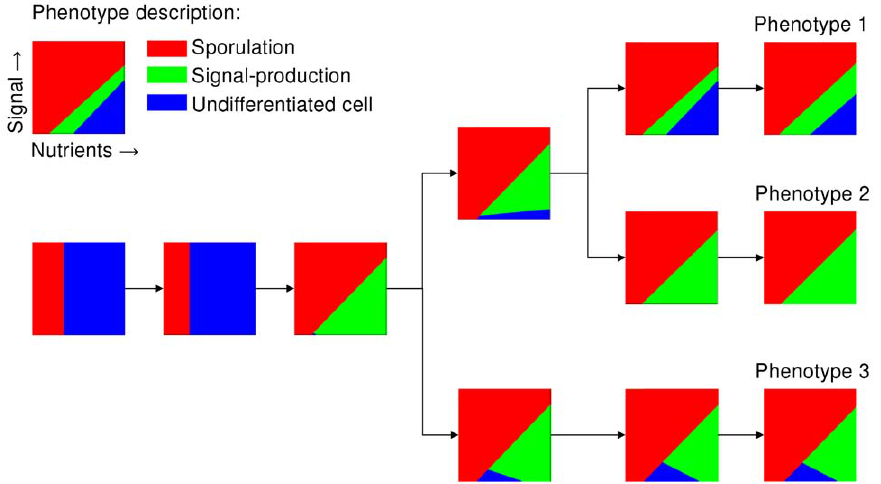
Figure 6. The evolution of different phenotypes shown by an evolutionary tree. The phenotypes that are associated with the three most- abundant genotypes that were present at the end of the simulation ( t ~ 550 : 000 ) are called phenotype 1, 2 and 3, each belonging to a distinct ecotype. The phenotypes that are projected on the evolutionary tree correspond to the ancestral and evolved genotypes at respectively time step 0, 100.000, 300.000, 400.000, 500.000 and 550.000 (from the left to the right). Each phenotype is shown by a small graph that shows the behavior of a cell for different environmental conditions: red area is sporulation; green area is signal production; and blue area is no differentiation. For the parameter settings see figure 5.